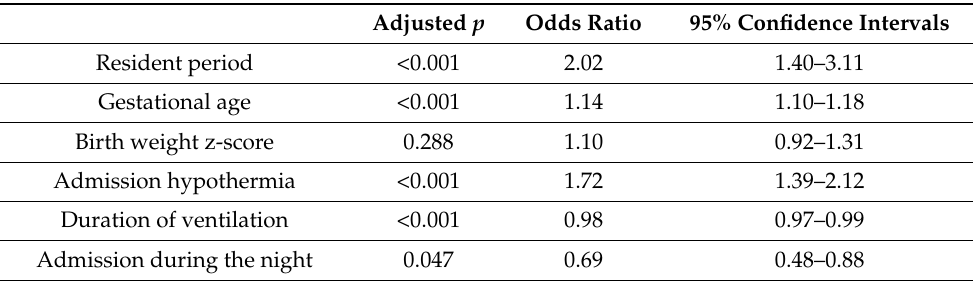
Table 3. Binary logistic regression analysis with survival to discharge from neonatal care as the outcome variable.